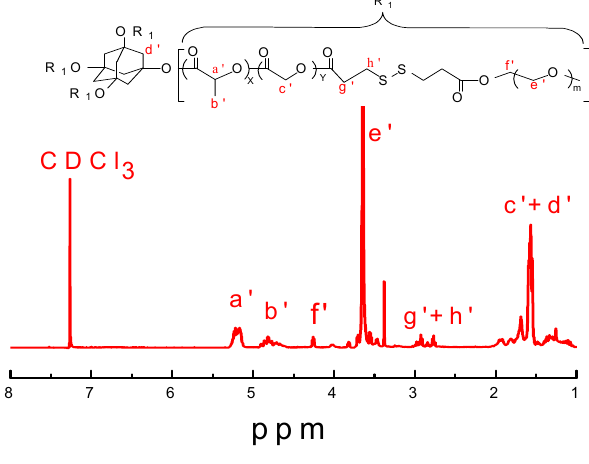
Figure 1. 1 H NMR spectrum of polymer 3 in CDCl 3 . Table 1. Molecular weight and particle size and polydispersity (PDI) of the polymers.